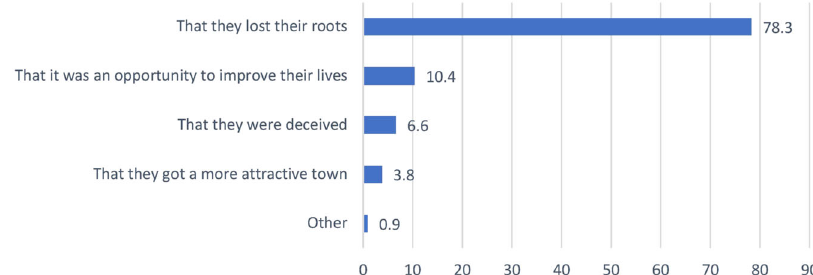
Fig. 7 Local community. Inhabitants of New Portomarín. What do you think the old people think about the forced removal?